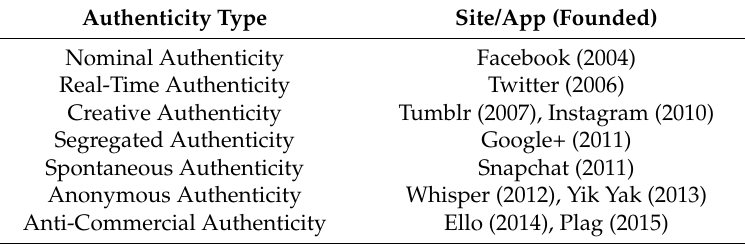
Table 1. Authenticity